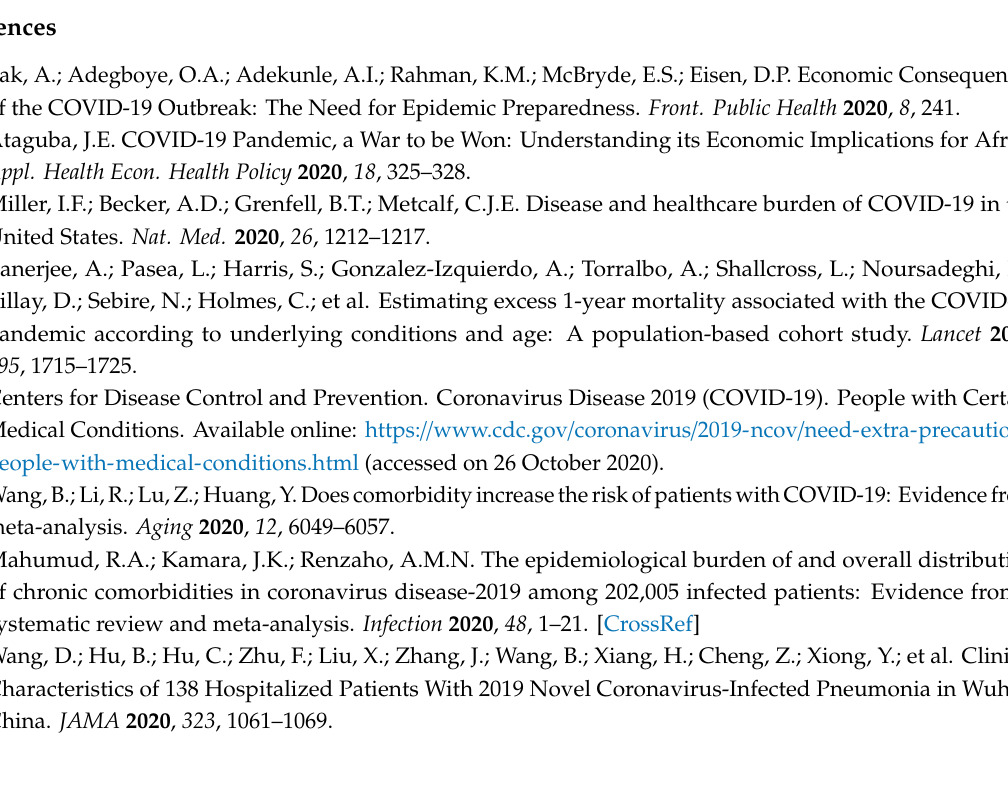
Table S1. Association between socio-demographic characteristics and having S-Covid-19-S in studied participants via logistic regression ( N = 8291). Table S2. Spearman correlation among